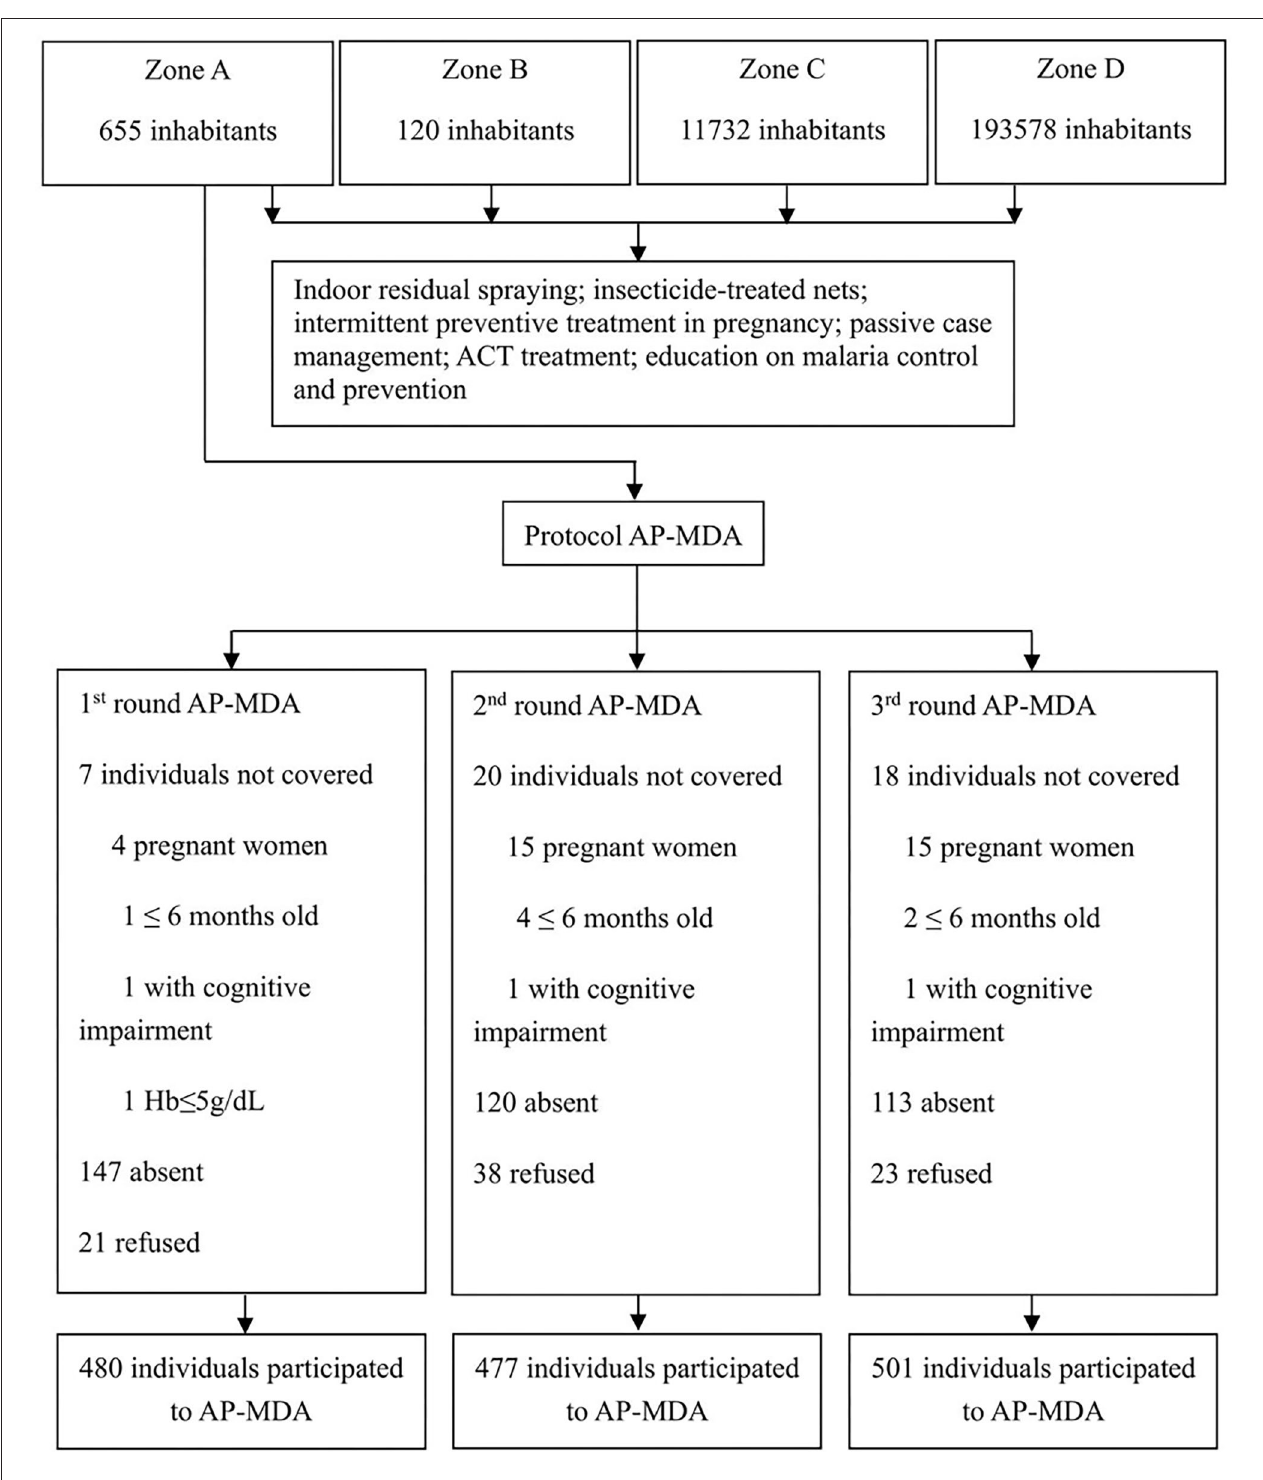
FIGURE 4 | Process of study implementation.